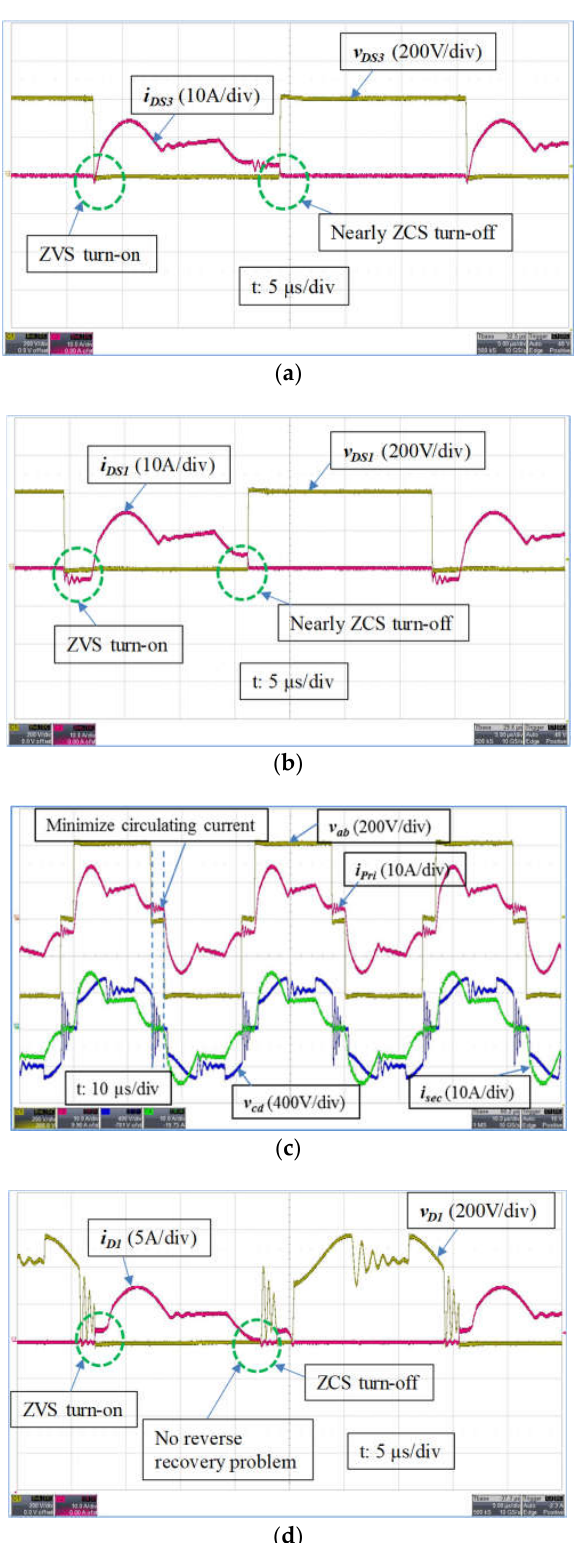
Figure 10. Experimental waveforms of the proposed converter at an output power of 3 kW. ( a ) Voltage and current waveforms of the lagging switch, S 3 ; ( b ) voltage and current waveforms of the leading switch, S 1 ; ( c ) voltage and current waveforms of the transformer; ( d ) voltage and current waveforms of the rectifier diode, D 1